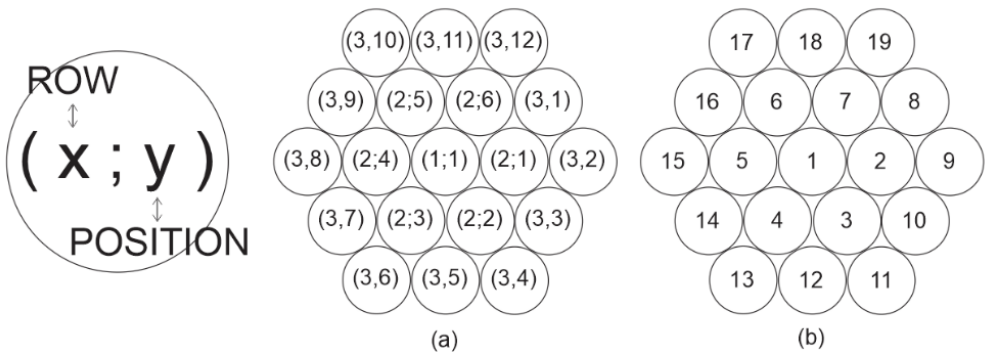
Figure 2. Virtual bundle position matrix representation for 𝑛 (cid:3033) = 19 : ( a ) Matrix indexes and ( b ) virtual fiber ID.